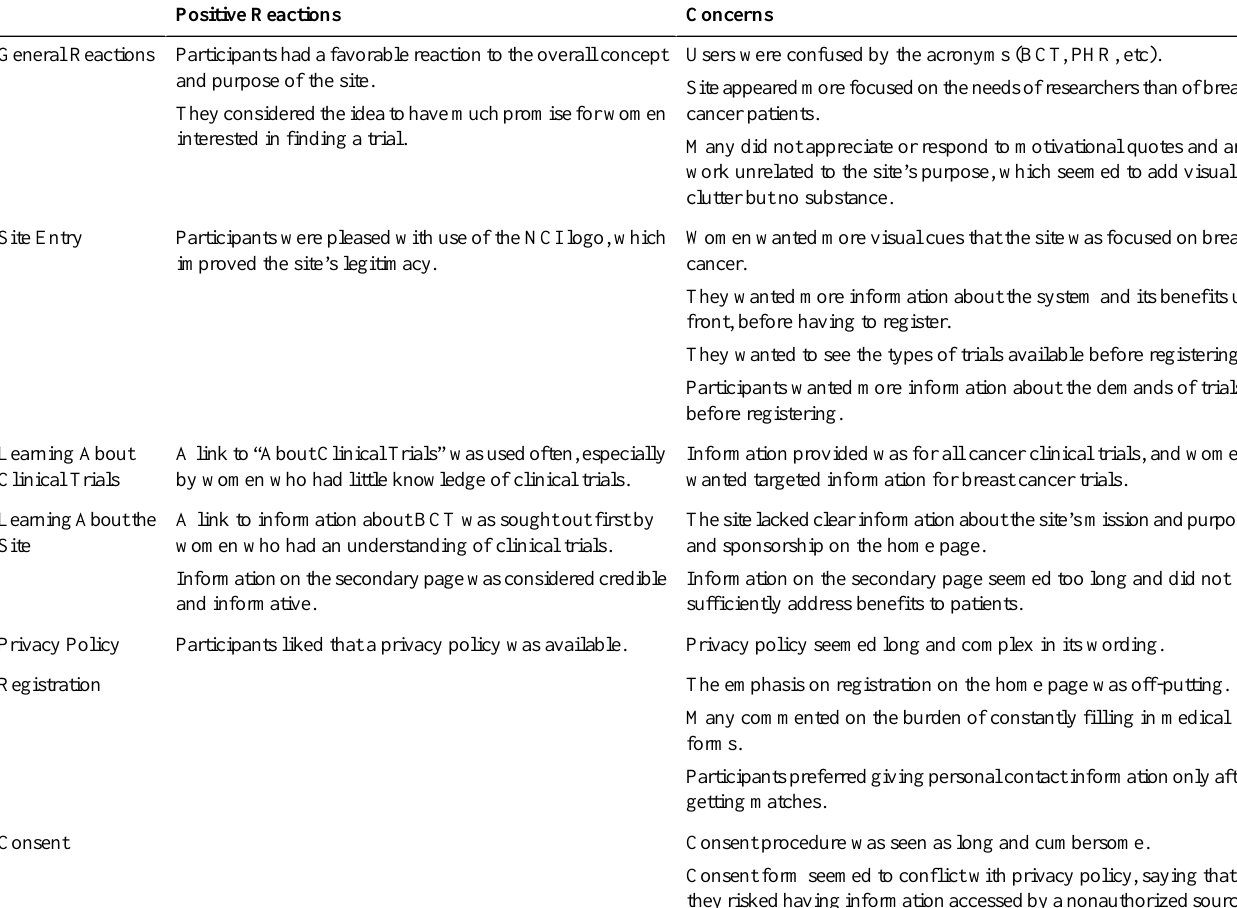
Table 2. Positive reactions and concerns to BCT prototype matching system among phase 1